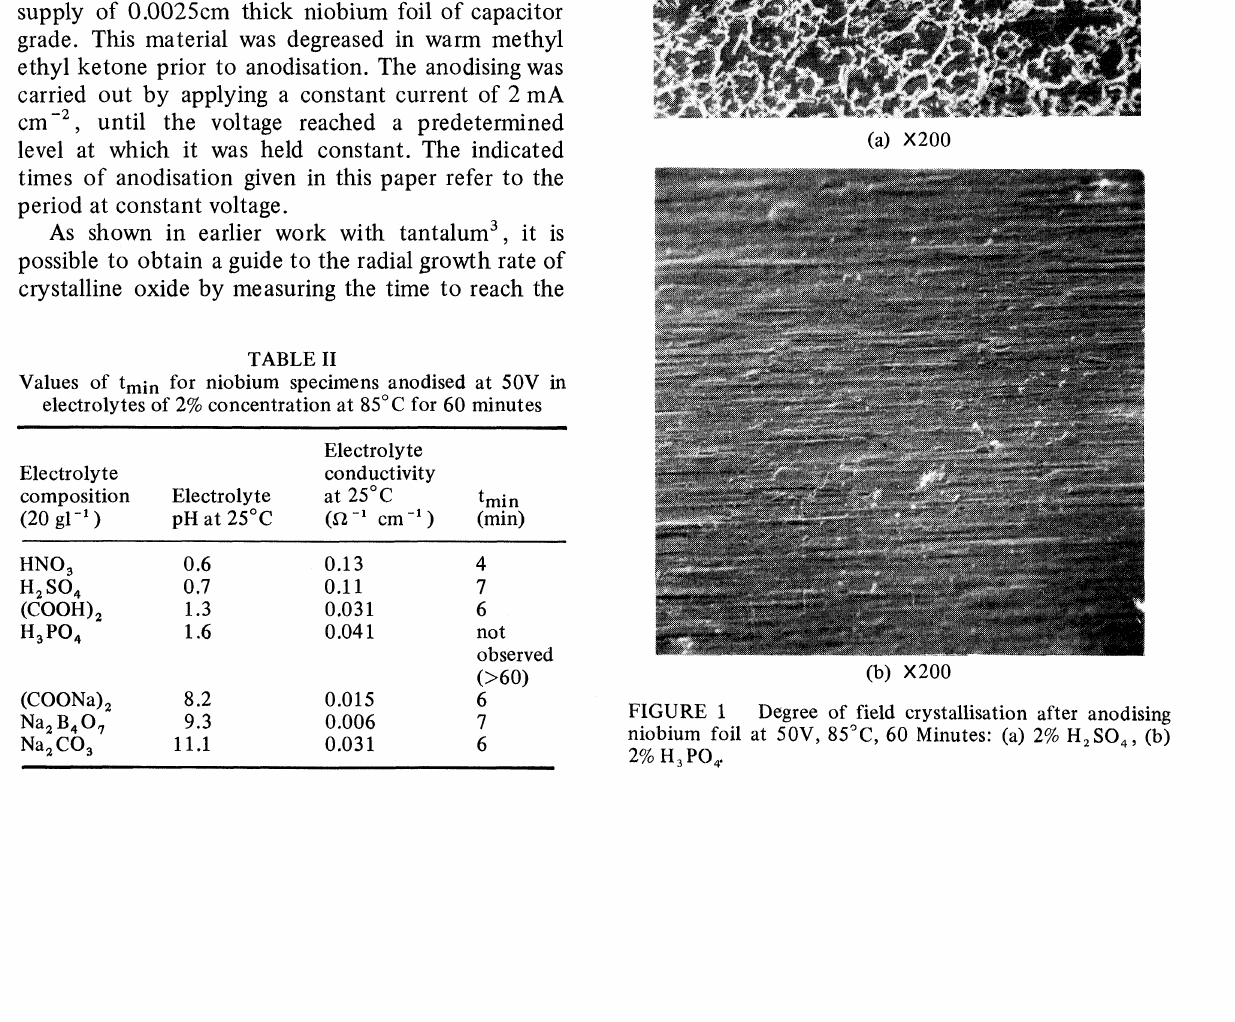
Degree of field crystallisation after anodising niobium foil at 50V, 85C, 60 Minutes" (a) 2% H2SO4, (b) 2% H3PO